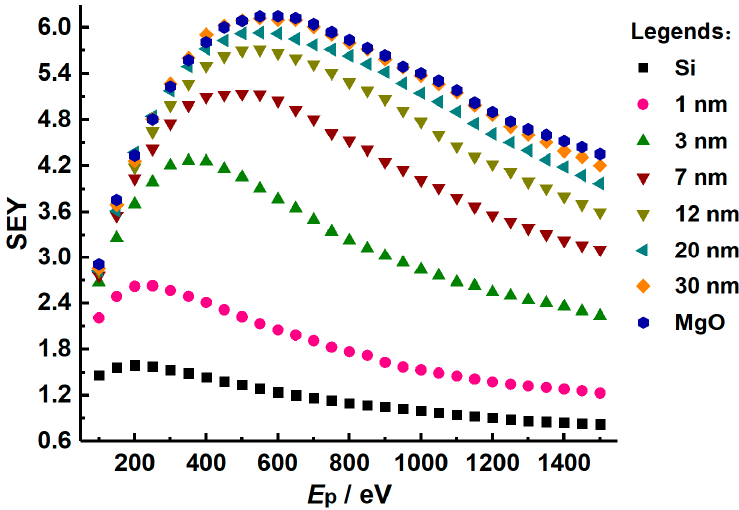
Figure 4. Measured SEY of MgO/Si double-layer samples.